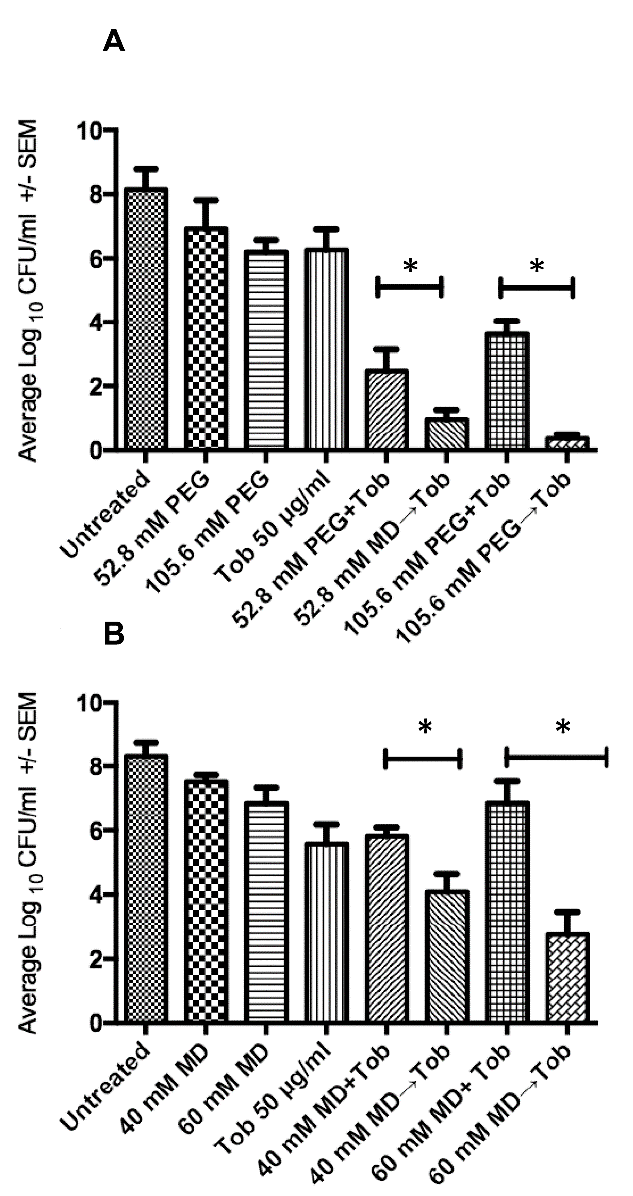
Figure 4. E ff ects of individual combined ( + ) or sequential ( → ) treatment with increased concentrations of osmotic compounds ( A ) maltodextrin (40 or 60 mM) and ( B ) PEG 3350 Da (25.8 or 105.6 mM), followed by tobramycin (Tob, 50 µ g / mL). Error bars represent the standard error of the means calculated from three biological replicates. Statistical significance was calculated using a one-way ANOVA and Tukey’s test for tobramycin with or without the osmotic compound (* p <